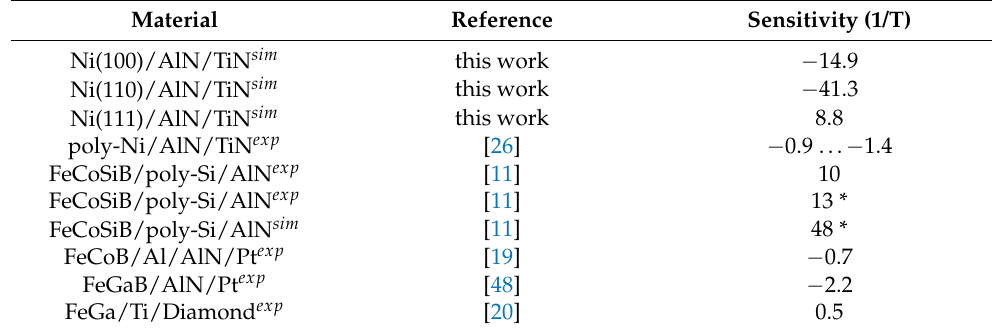
Table 1. Comparison of simulated and experimental sensitivities of the natural frequency of elec- tromechanical system based on magnetoelectric sensors. (Values calculated according to Equation (10) if not given in the reference). * Sensitivity for the second